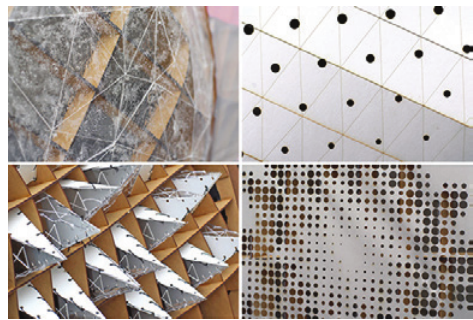
Figure 7. Details revealing different digital strategies for the solutions of the skin that cover shared curvature of the whole installation. From top left: triangulated transparent acrylic covered with silicone, laser perforated and engraved white cardboard, surface faces offset and extruded to acrylic pyramids that are bound together with a tread, laser perforated metallic-coated